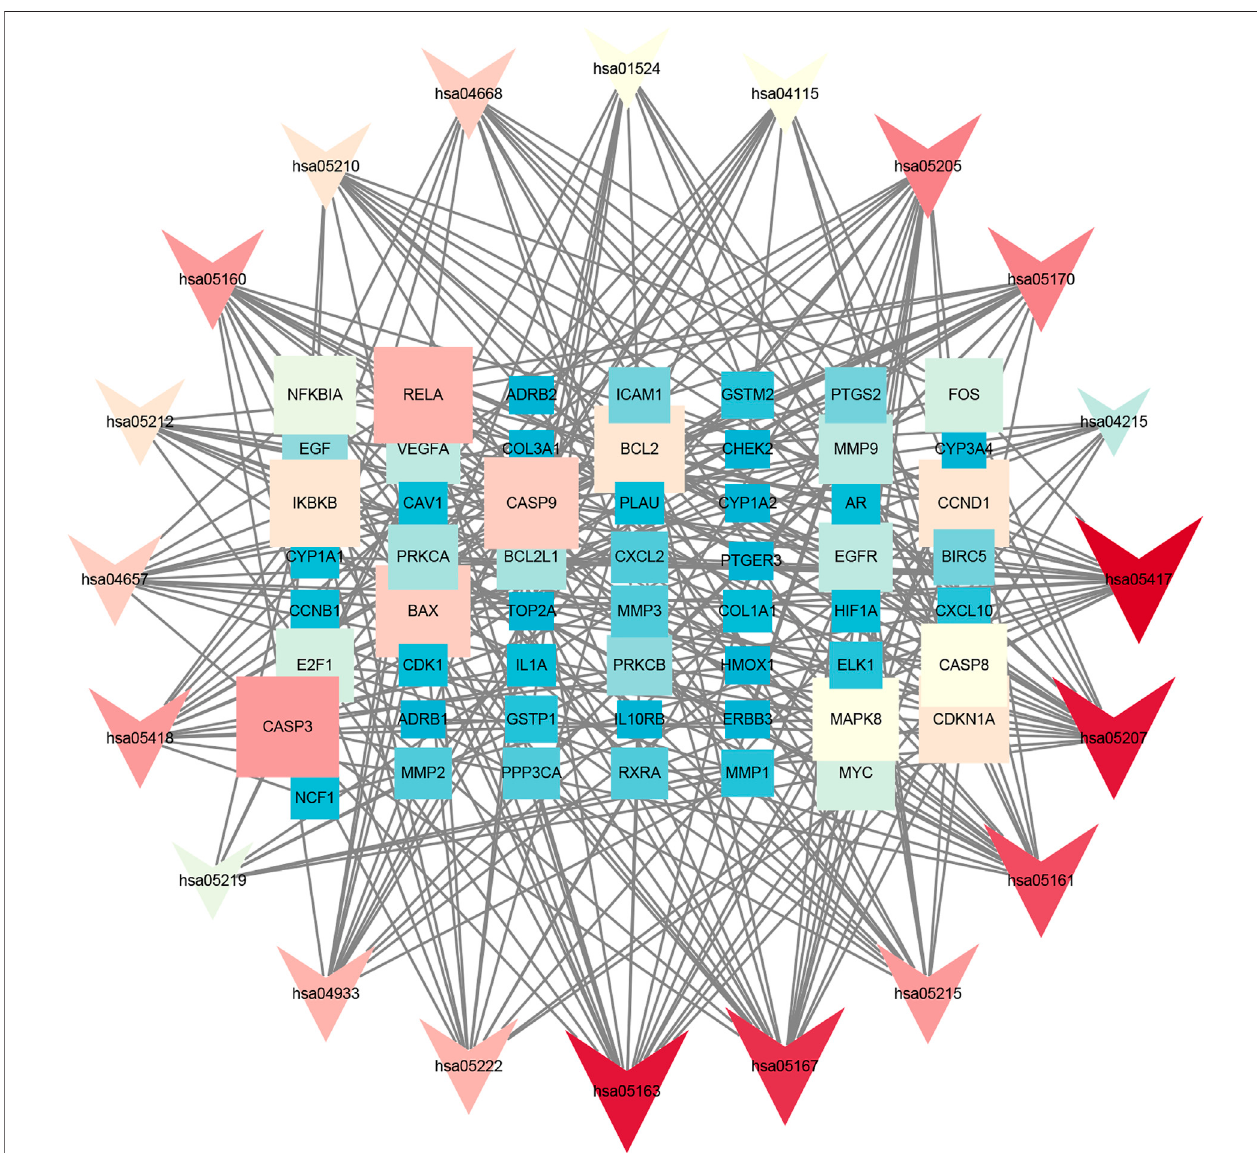
FIGURE 5 | Kyoto Encyclopedia of Genes and Genomes (KEGG) analysis in Cytoscape 3.8.2 software. The KEGG screening was conducted using Cytoscape 3.8.2 software. The association network between target genes and pathways was constructed. The target genes and KEGG pathways were scored according to the connectivity degree. A total of eight high expression of target protein include CASP3, BAX, RELA, EGFR, BCL2, CCND1, MAPK8, and VEGFA. The pathway involved in this process mainly includes the apoptosis pathway by KEGG analysis.